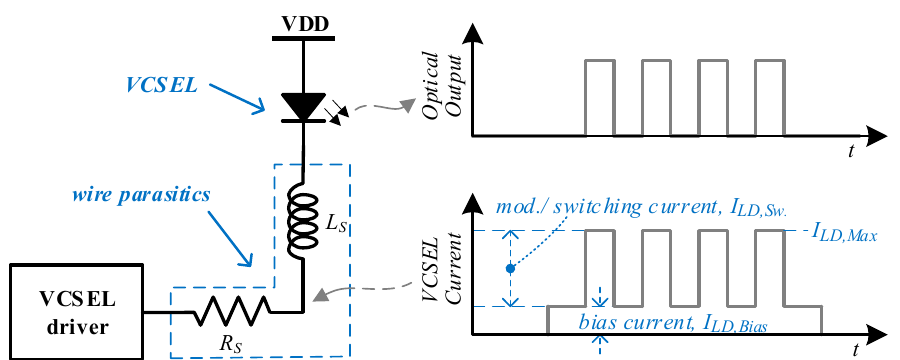
Figure 1. Common Anode (CA) vertical-cavity surface-emitting laser (VCSEL) connection with its driver circuit, in the presence of wire parasitics consisting of resistance and inductance.